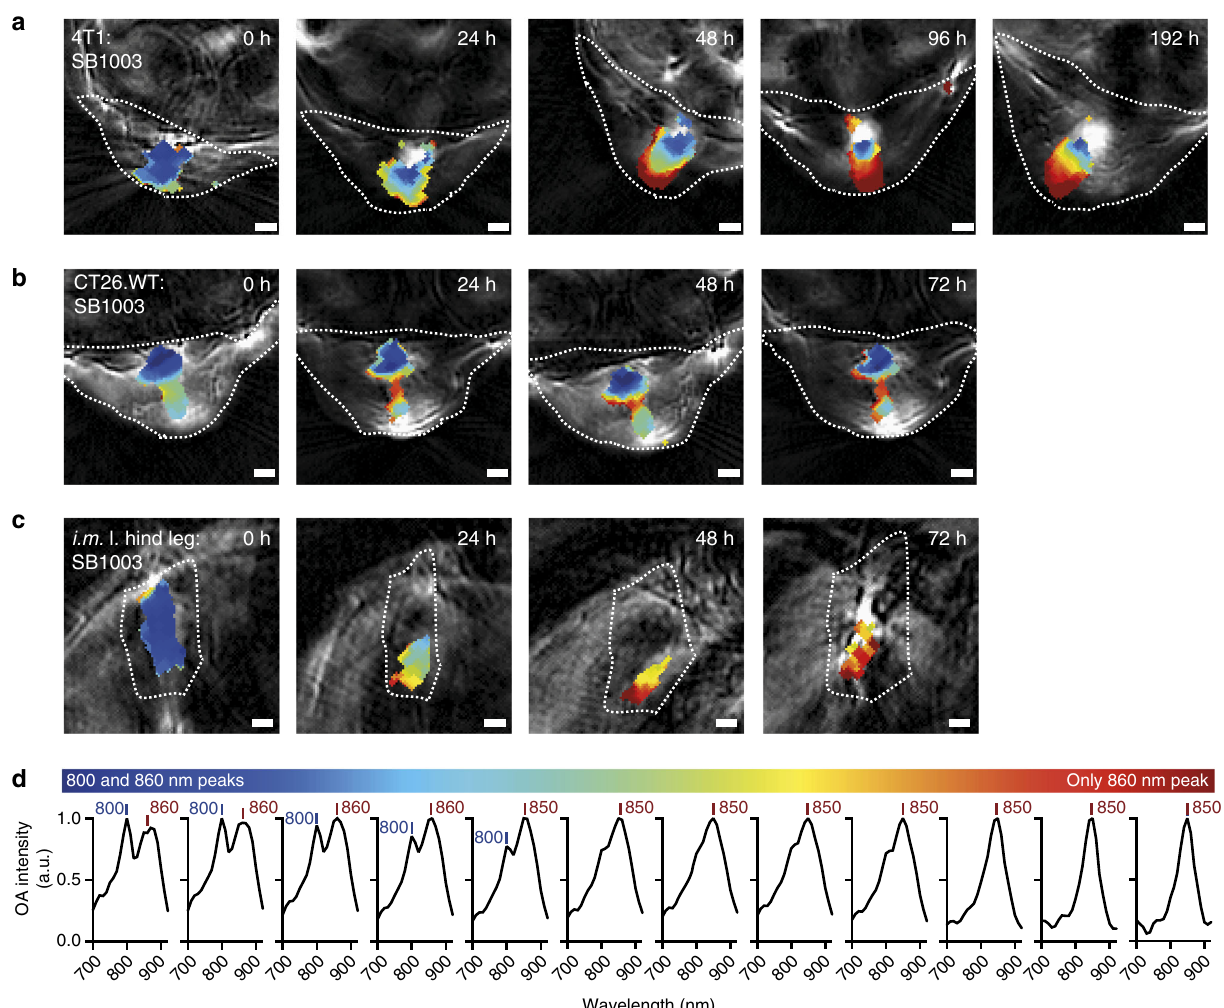
Fig. 3 Spatiotemporal change of the bacterial spectral signature in the tumor environment and the muscle. A 4T1 ( a ) and a CT26.WT ( b ) tumor-bearing mouse intratumorally injected with Rba. capsulatus SB1003 is shown together with the hind leg muscle with the same injection ( c ). Shown are representative reconstructed images overlaid by unmixed pixels in false colors. Color coded regions indicate a mixture of 800 nm/860 nm peaks or predominance of the 860-nm peak as visualized in d . Shown are mean spectra of all regions of the same color. Unmixed pixels are shown as black if automatic peak assignment failed. Strong signal (white) in the reconstructed images at 720 nm relates to high absorption by blood or other absorber that has not been identi fi ed by the unmixing procedure. Data for all mice at all timepoints can be found in Supplementary Figure 14 ( a n = 3, b n = 3, c n = 2). The analyzed region of interest (i.e., tumor) is indicated as a dotted line. All scale bars, 1